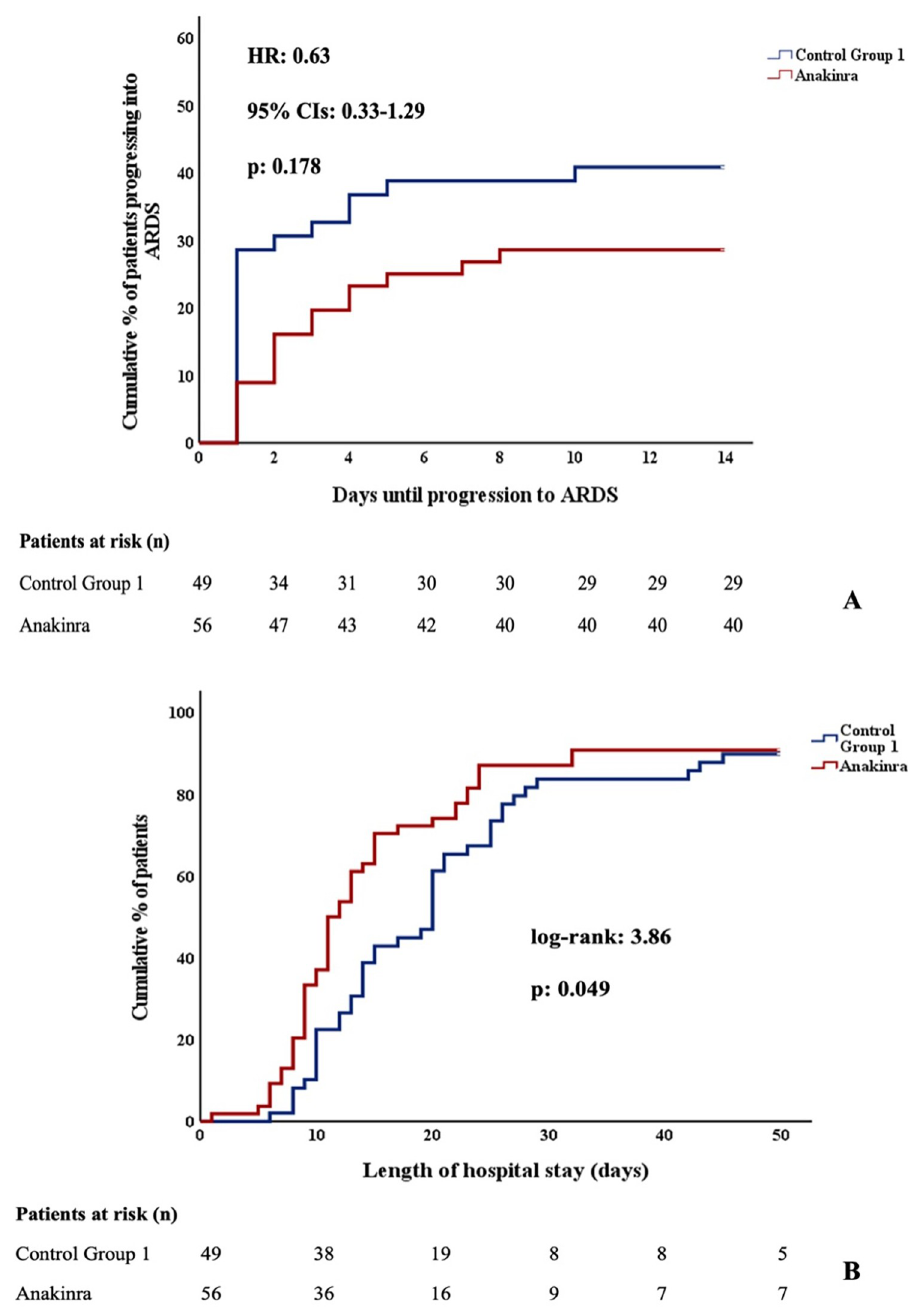
Fig 2. Disease progression at day 14 from hospital admission. Distribution of the WHO-CPS scores at day 28 of patients admitted for COVID-19 with baseline SuPAR � 6 ng/mL and non-severe respiratory failure who received and did not receive anakinra (Control Group 1). Comparison is done by unadjusted ordinal regression analysis; the ORs of the 95% CIs are provided. COVID-19 = coronavirus disease 2019. SuPAR = soluble urokinase plasminogen activator receptor. OR = odds